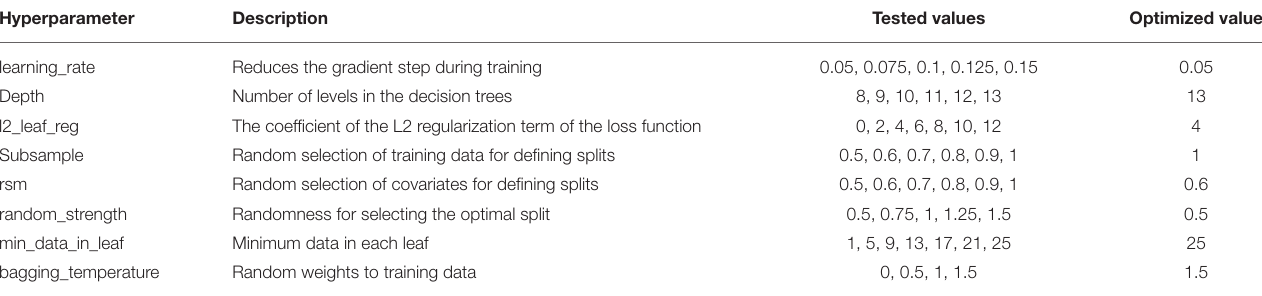
TABLE 3 | CatBoost hyper parameter used in the randomized search (2,500